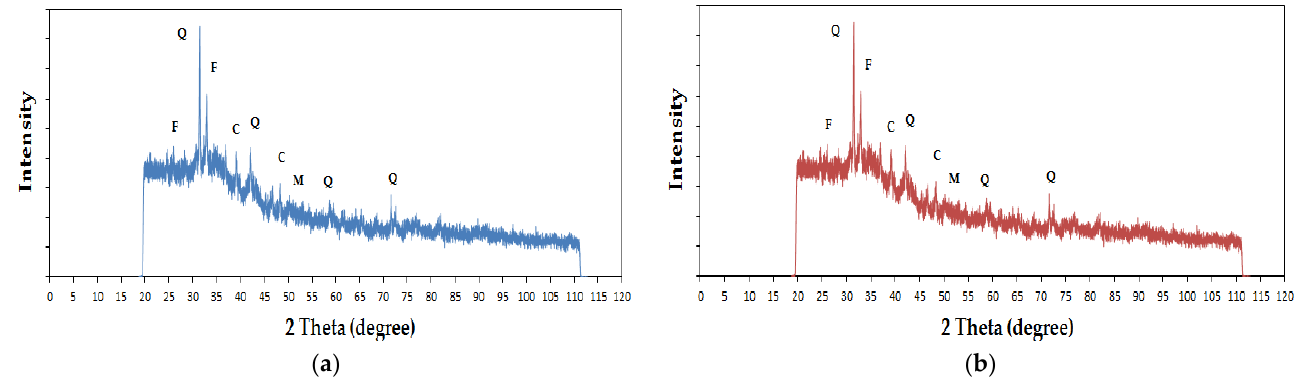
Figure 12. XRD analysis of geopolymer binders for ( a ) sample 6M and ( b ) sample 6MX1, where Q represents quartz, F — feldspar, C — calcite and M — mullite.